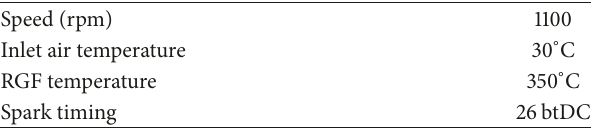
Table 2: Operating conditions used in this